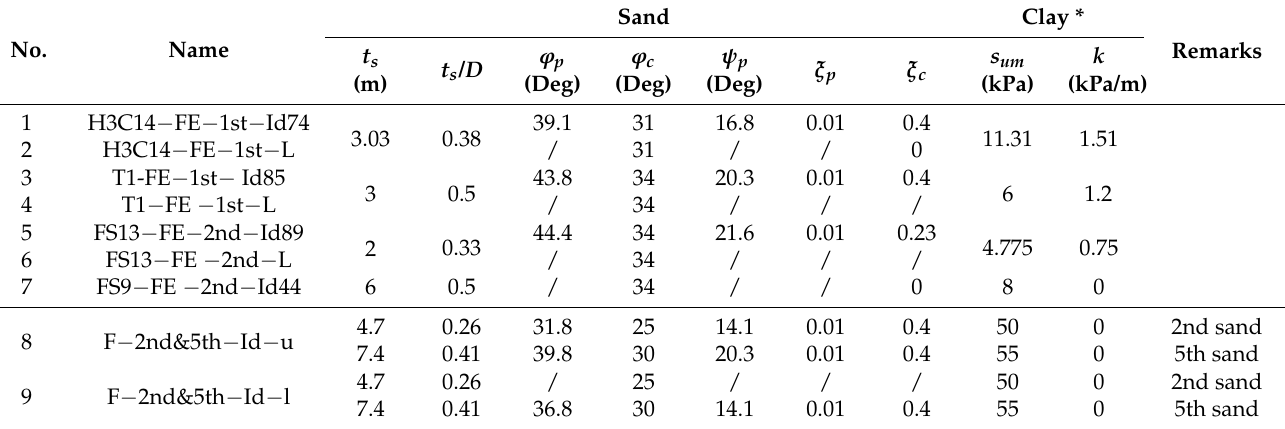
Table 2. Summary of LDFE